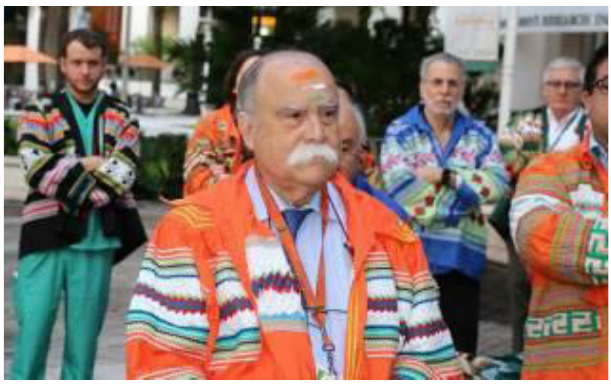
Fig. 13 - Prof. Salerno was elected Member Iron Arrow, the highest honor of Miami University in